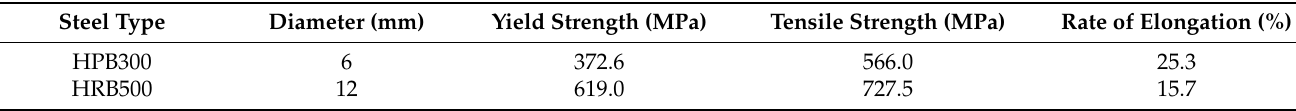
Table 2. Mechanical properties of steel